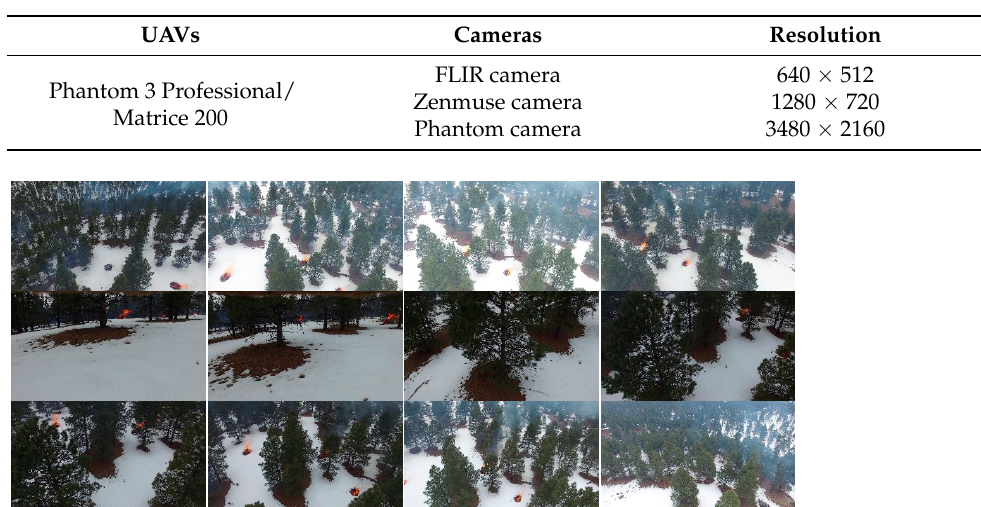
Table 1. Technical specifications of the UAVs and cameras used in the FLAME dataset and the resolution of the samples acquired.